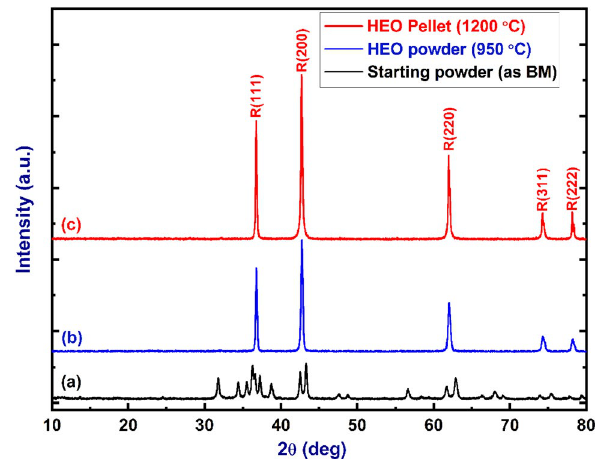
Fig. 5 Expanded view of XRD pattern of HEO for (a) (111) peak from 30° – 40° and (b) (220) peak from 60° – 64° to observe the peak evolu- tion with changing temperature